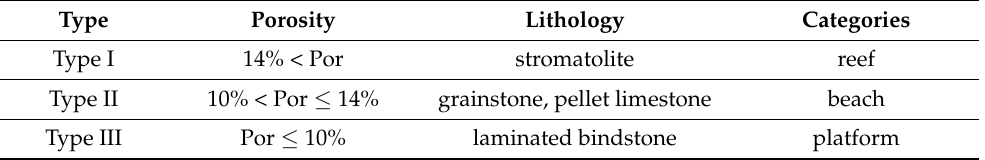
Table 1. Reservoir classification table based on the analysis of geological conditions, such as cores and outcrops, as well as prior information, such as sediments, physical parameters and